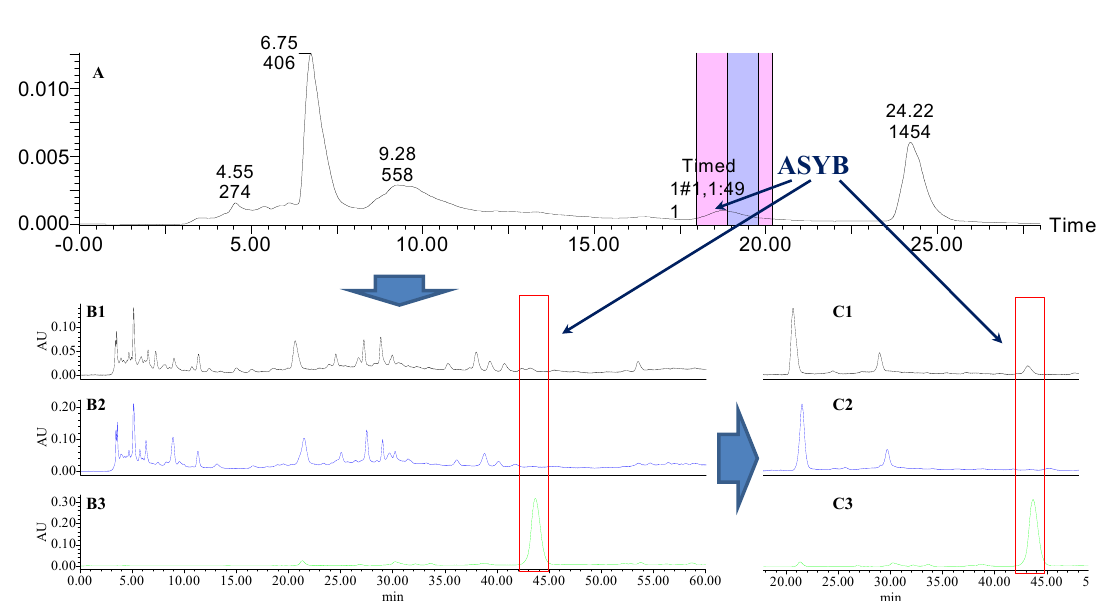
Figure 15. The preparative and analytical chromatograms of the depletion of ASYB from CF-PS. ( A ) preparative chromatogram at 270 nm; ( B1 ) analytical chromatogram of CF-PS at 270 nm; ( B2 ) analytical chromatogram of CF-PS-B at 270 nm; ( B3 ) analytical chromatogram of ASYB depleted from CF-PS at 270 nm. ( C1 ) analytical chromatogram of CF-PS at 400 nm; ( C2 ) analytical chromatogram of CF-PS-B at 400 nm; ( C3 ) analytical chromatogram of ASYB depleted from CF-PS at 400 nm.